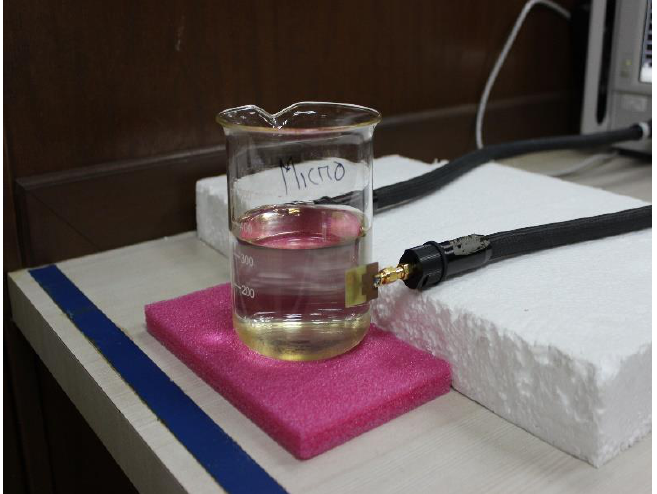
Figure 15. Measurement setup of the proposed UWB antenna sensor. Sensors 2018 , 18 , x